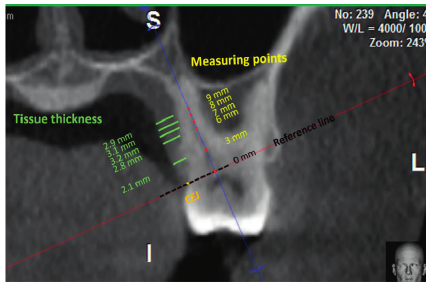
Figure 3: A specific section on the midpalatal root of a maxillary first molar in the frontal plane has been set. On each tooth, the palatal soft tissues at a distance of 3, 6, 7, 8, and 9mm from CEJ were marked for measurement. Table 1: Demographic data of the study